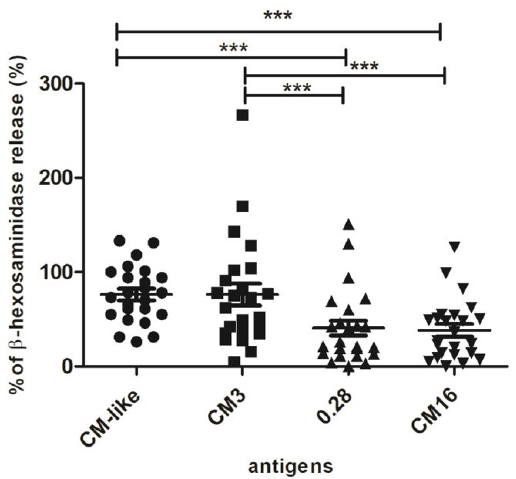
Figure 5. Basophil activation assay with 23 sera from wheat allergic patients. RBL-SX38 cells were stimulated with 1 µg/mL of CM3, 0.28, CM16 proteins and with CM-like extract from Bobwhite. *** p < 0.0001.